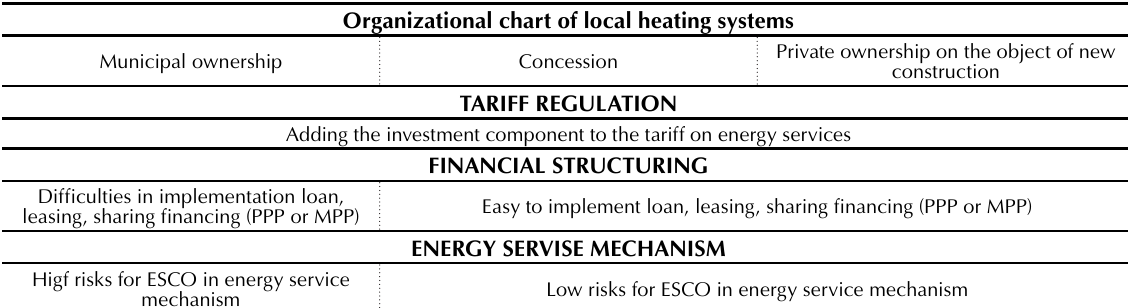
Table 1. Organizational and financial mechanisms for allocating investment resources under various legal schemes for managing heat supply